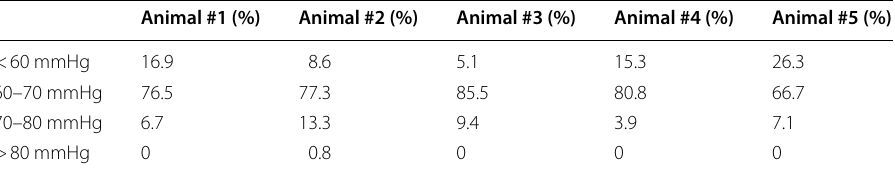
Table 2 Proportion of time at specific blood pressure ranges (ranges are inclusive unless otherwise denoted with less than or greater than sign) using 1‑min bin to calculate mean arterial blood pressure during the critical care phase (255